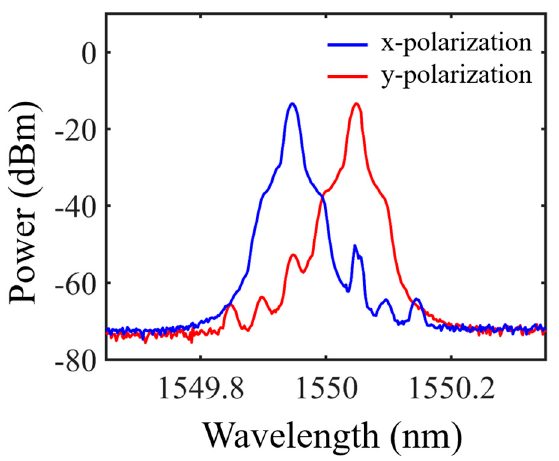
Figure 2. Optical spectra of the output of the DP-DPMZM at x polarization state and y polarization state centered at 7 state centered at 7 GHz.